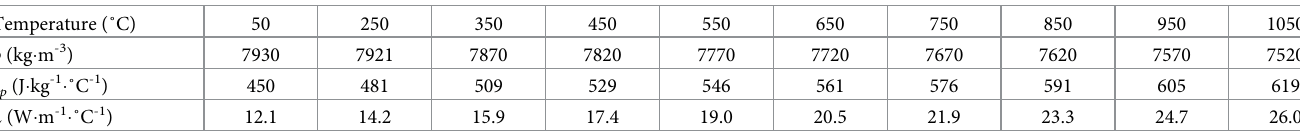
The original parameters and their fitting polynomial curves are shown in Fig 7. The principle of an infrared camera is based on the measured radiation power of the observed surface. Hence, it is critical to obtain the emissivity of materials under experimental conditions. The empirical values of the emissivity are mostly used in the experiment of the jet impingement heat transfer [29, 30]. However, the emissivity of a material is not constant and depends on the environmental temperature, surface characteristics, shooting distance, and humidity [31–33]. Another common approach is to coat the test surface with a black paint of known emissivity [10, 24], but it is not suitable for the study of the jet impingement heat trans- fer because it affects the flow field and temperature field at the interface, altering the accuracy of the measured results. Herein, the contrast method is employed to obtain the emissivity of the heat transfer sur- face, as detailed below. Firstly, the whole test device is heated to a certain temperature in a cali- brated heating furnace. Secondly, the surface is covered with an insulating material to reduce heat consumption. Thirdly, the device is taken out from the furnace and placed in an image Table 2. Thermophysical parameters of the austenitic 304 stainless steel. Temperature